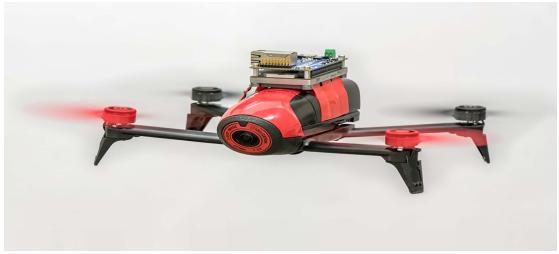
Figure 3. The mounted tx2 on the modified bebop